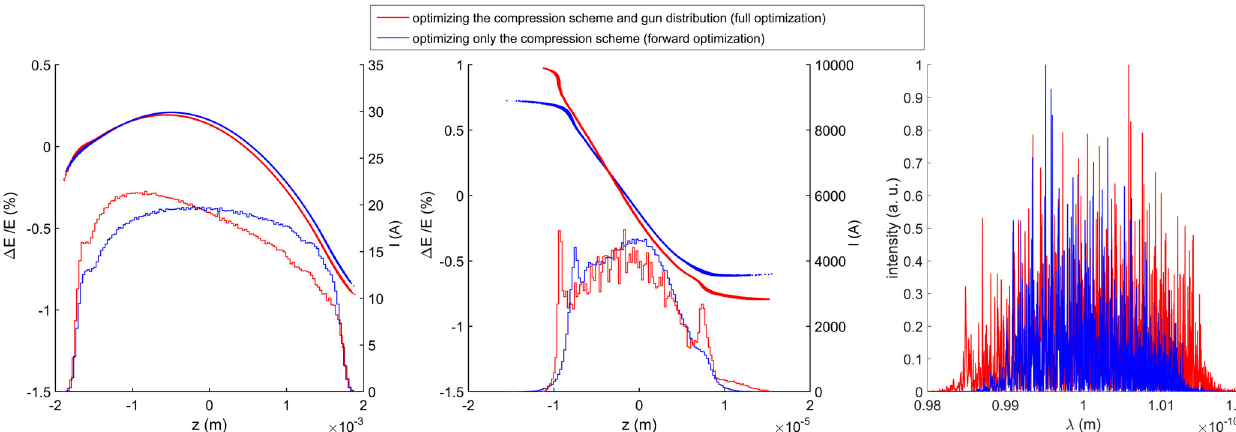
FIG. 5. Left: Comparison of the longitudinal phase space of the electron beam and their current profiles at the position of the laser heater. In blue the initial distribution (A) with a standard flat current profile and in red the modified source distribution (A ” ) with a ramped current profile, resulting from the backward optimization. Center: Comparison of the longitudinal phase space of the electron beam and their current profiles at the entrance of the undulators. Although the current profiles and bunch lengths are similar, the energy chirp is 50% larger for the input distribution with a ramped profile (red). Right: XFEL radiation from the Aramis undulators; the pulse bandwidth (FWHM) is 50% larger for the input distribution with a ramped profile